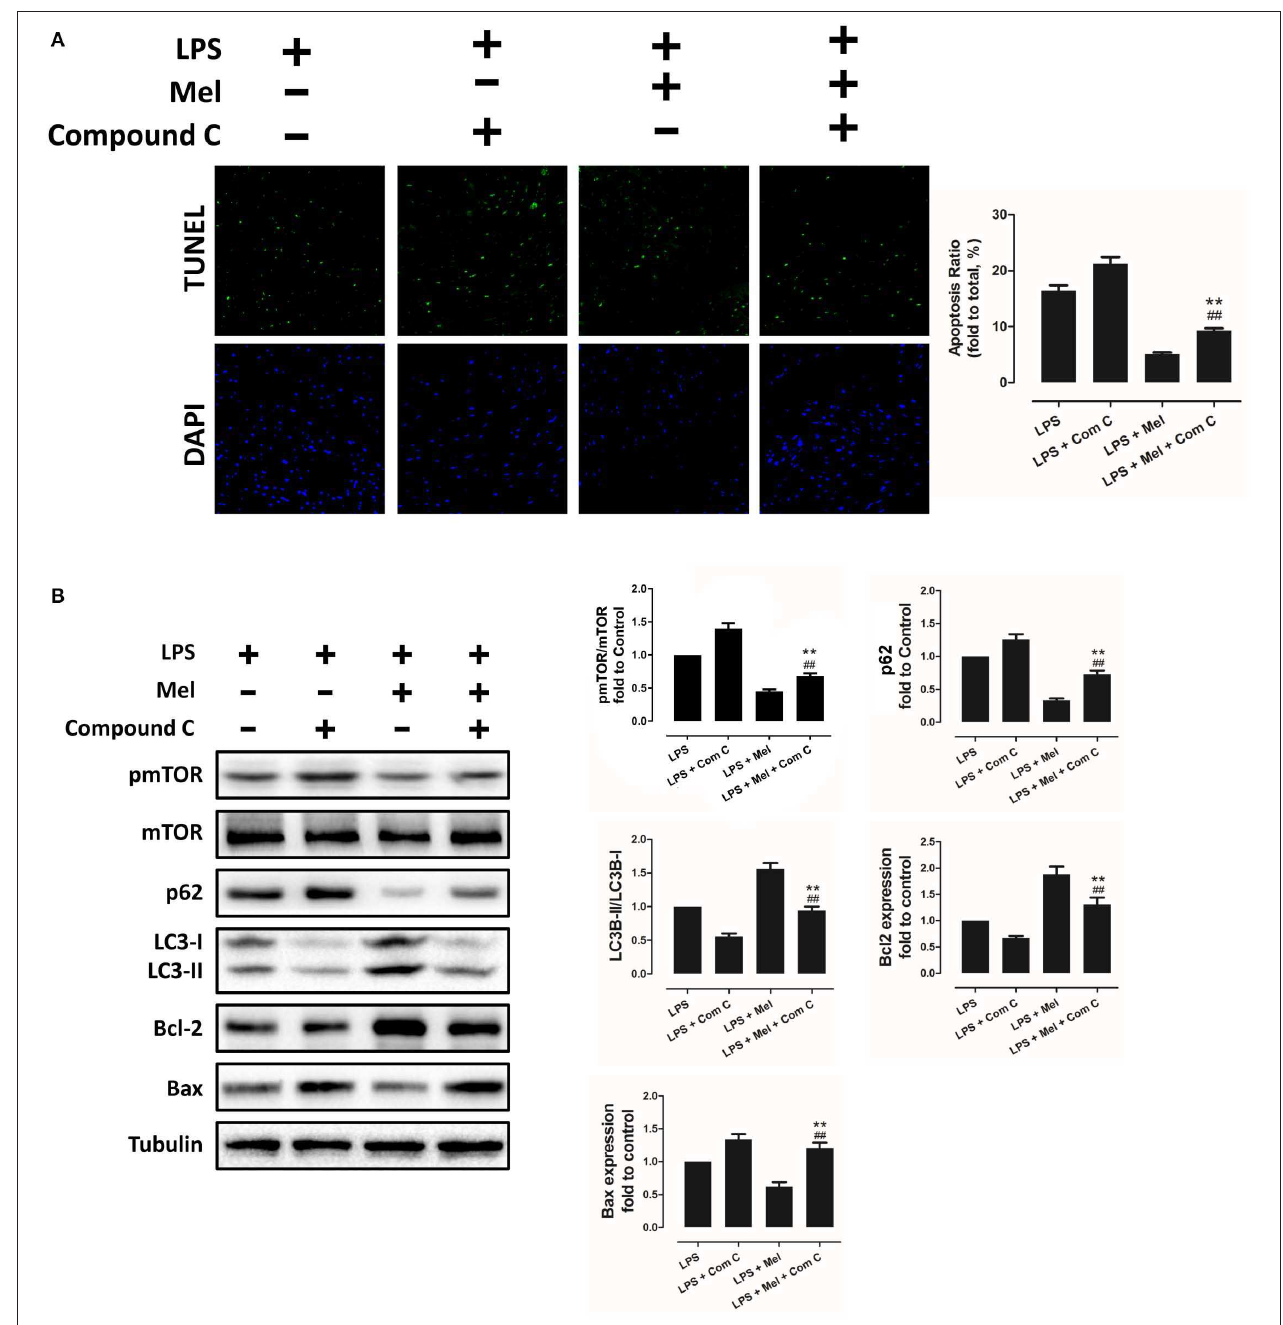
FIGURE 5 | Compound C reversed melatonin-induced cardiac protection via inhibiting autophagy activation and increasing apoptosis. (A) Representative images of TUNEL staining and quantitative analysis of the apoptosis ratio. (B) Representative bands of western blot and quantitative analysis of pmTOR phosphorylation level, p62 expression, LC3B-II/LC3B-I ratio, Bcl-2 expression, and Bax expression. n = 6, ** P < 0.05 vs. the LPS + Compound C group, ## P < 0.05 vs. the LPS + melatonin group. Mel,